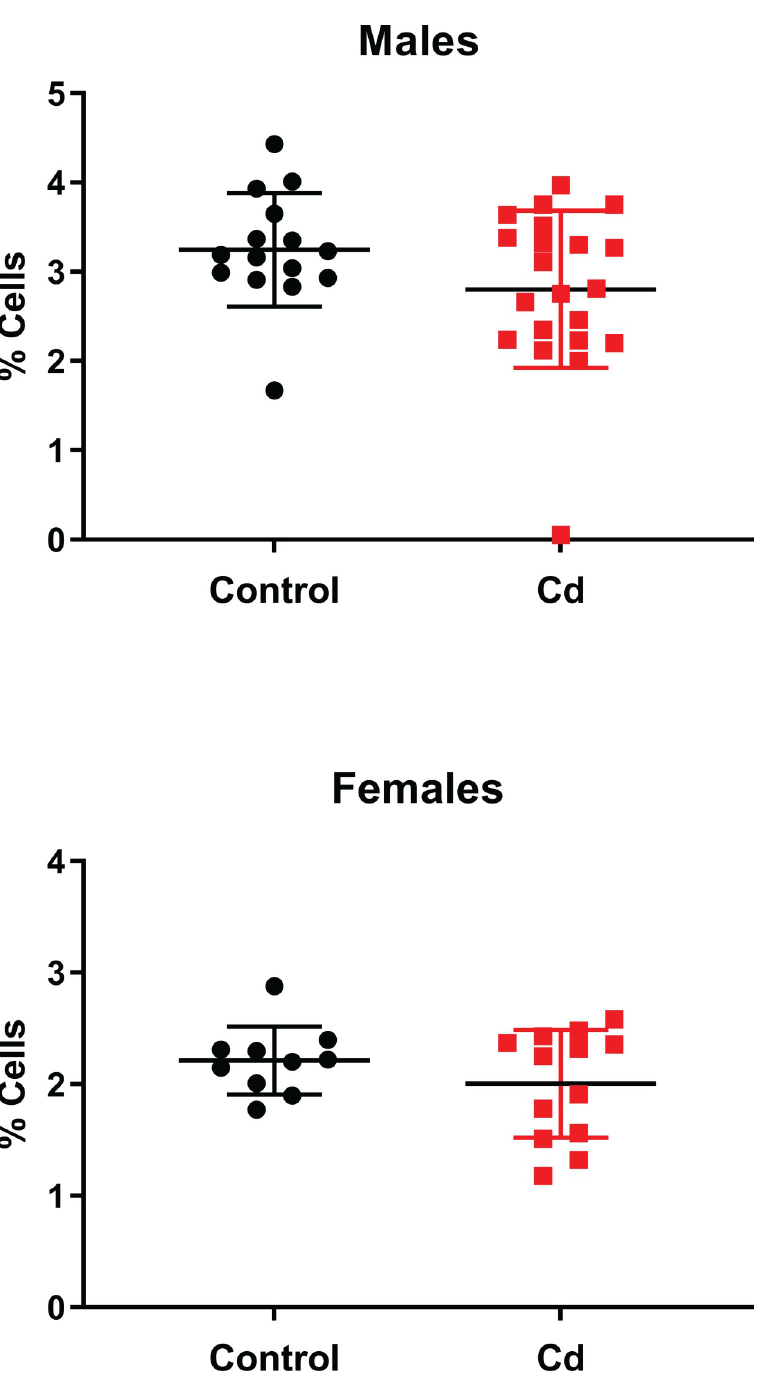
Fig 2. Analysis for Treg spleen cell percentages of Cd-exposed NOD offspring. At 18 weeks (females) and 22 weeks (males), the spleens of the offspring were ablated and processed for flow cytometric analysis. CD4 + CD25 + FOXP3 + were quantified. Data are shown as mean ± SD. Males N = 15–21; Females N =